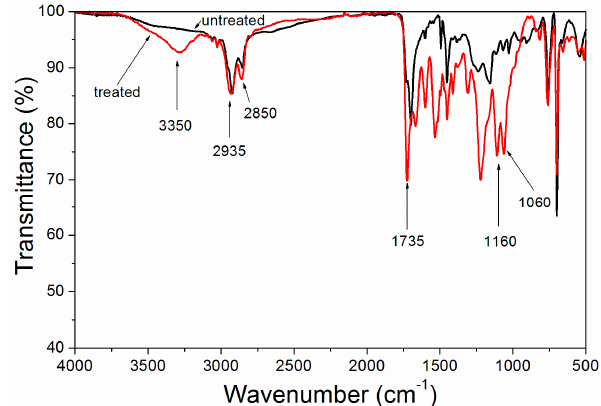
Figure 4. The infrared spectrum of wheat straw powder: untreated and treated with alkaline hydrogen peroxide.